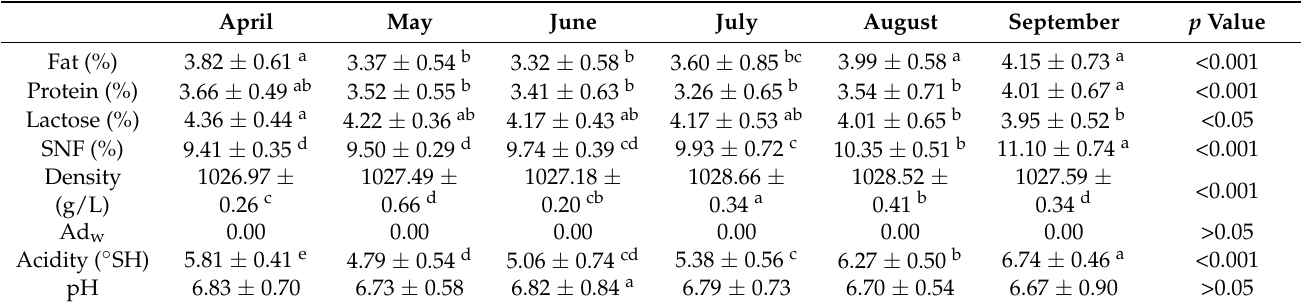
Table 2. Means and their standard deviations (SD) of the physical and chemical indicators of goat’s milk depending on the month of